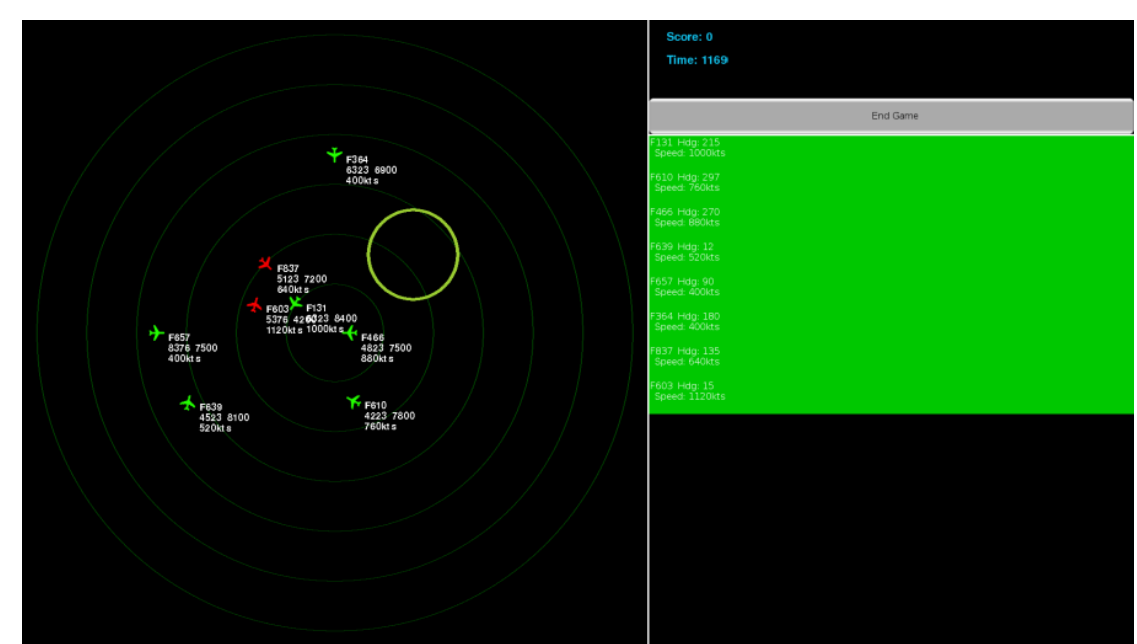
Figure 3. Human–computer interaction interface. A group of aircraft are generated and displayed on the left area, with specific information of each aircraft listed on the lower right area. The upper right area serves for displaying time and